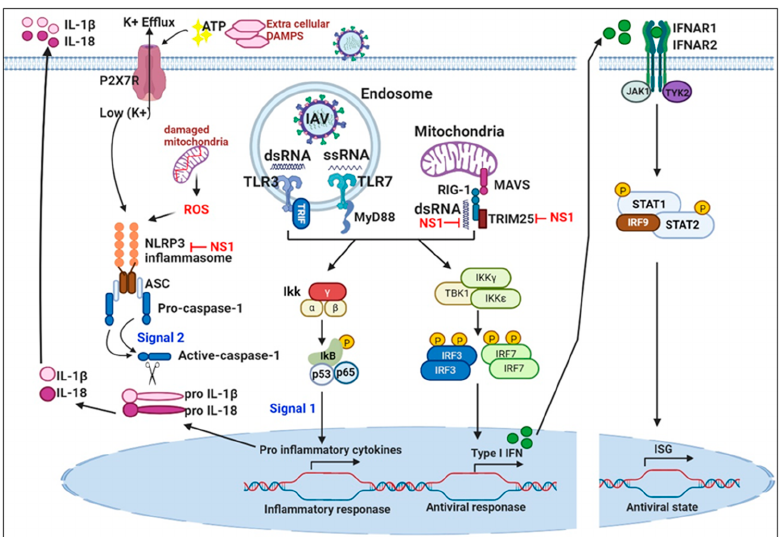
Figure 2. The intracellular cytoplasmic pattern-recognition receptor RIG-I is essential for the control of RNA virus infection. Upon IAV recognition, RIG-I recruits the adaptor MAVS protein to activate the IKK α –IKK β and TBK1–IKK ϵ complexes, which are responsible for the activation of the IRF 3 and IRF7 transcription factors. These transcription factors then translocate into the nucleus and cooperatively induce IRF dependent type I IFNs and NF- κ B (nuclear factor kappa-light-chain-enhancer of activated B cells) dependent pro-inflammatory cytokines and chemokines. This is followed by the binding of the IFNAR1 and IFNAR2 to their cognate receptor, which leads to the transcriptional activation of ISGs by the JAK / STAT signaling pathway. The products of ISGs are key factors limiting pathogen spreading. Moreover, ssRNA from IAVs can prime the inflammasome by activating a TLR inducing NF- κ B activation and the expression of NLRP3, ASC, and preforms of IL-18 and IL-1 β . A second activation signal is provided by the oligomerization of the NLRP3 complex and recruitment of ASC and procaspase-1, allowing the processing and cleavage of pro-IL-1 β and pro-IL-18 precursors into their bioactive mature forms (IL-18 and IL-1 β ). NLRP3 can be activated by imbalances in potassium ion concentration in intracellular vesicles through the ATP-gated P2 × 7 channel and responses of mitochondrial reactive oxygen species. This figure was created using BioRender. RIG-1; retinoic acid-inducible gene-1, MAVS; mitochondrial antiviral signaling adaptor, IKK α ; nuclear factor of kappa light polypeptide gene enhancer in B-cells inhibitor (I κ B) kinase α , IKK β ; I κ B kinase β , IKK (cid:15) ; I κ B kinase (cid:15) , TBK1; TRAF family member-associated NF-kappa-B activator (TANK)-binding kinase 1, IRF; interferon-regulatory factors, IFNs; Interferons, NF- κ B; Nuclear Factor kappa-light-chain-enhancer of activated B cells, IFNAR1; Interferon Alpha And Beta Receptor Subunit 1, IFNAR2; Interferon Alpha And Beta Receptor Subunit 2, ISGs; interferon-stimulated gene, JAK / STAT; Janus kinase (JAK) / signal transducer and activator of transcription (STAT), ssRNA; single stranded RNA, TLR; Toll like receptor, NLRP3; nucleoside oligomerization domain (NOD), leucine-rich repeat (LRR), and pyrin domain (PYD) domain-containing protein 3, ASC; Apoptosis-associated speck-like protein containing a CARD, IL-18; Interleukin 18, IL-1 β ; Interleukin 1 β , ATP-gated P2X7; Adenosine triphosphate (ATP)-gated purinergic P2X7